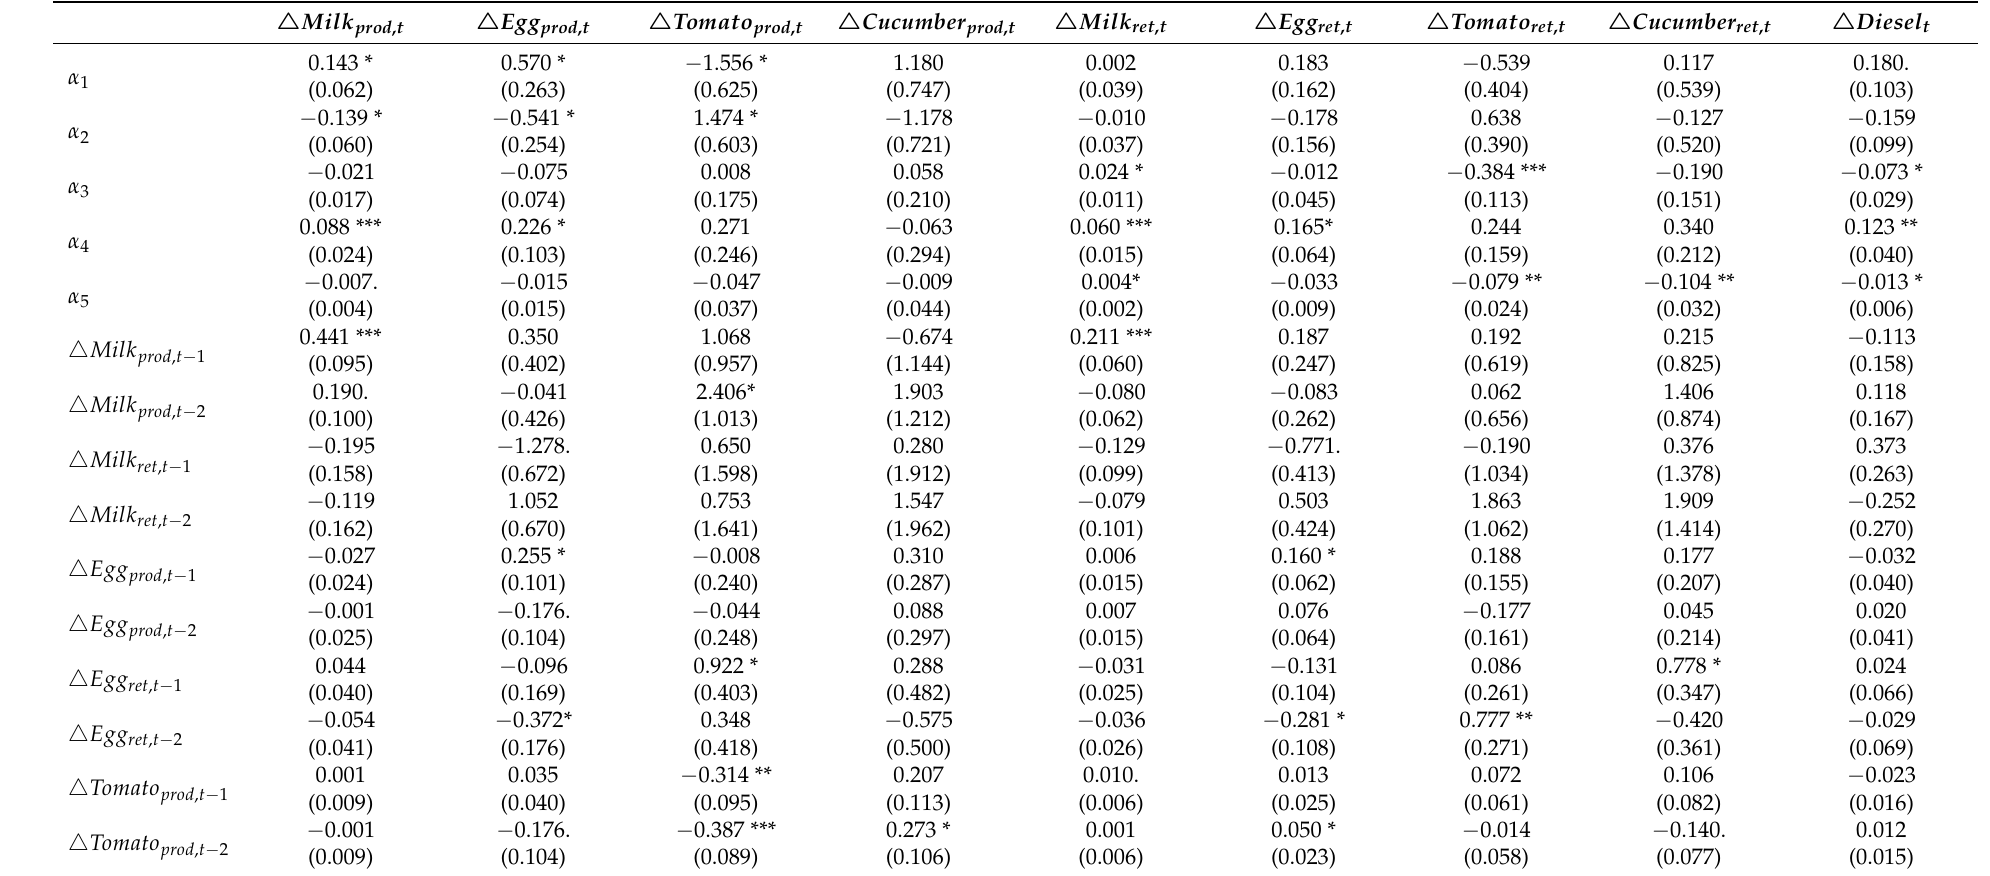
Table 6. Vector error correction model